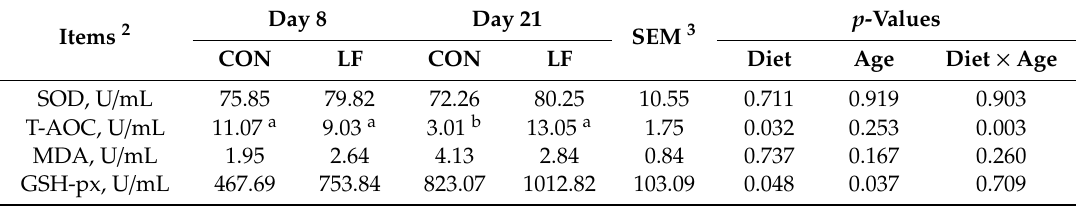
Table 4. E ff ects of lactoferrin on serum antioxidant parameters of suckling piglets 1 .